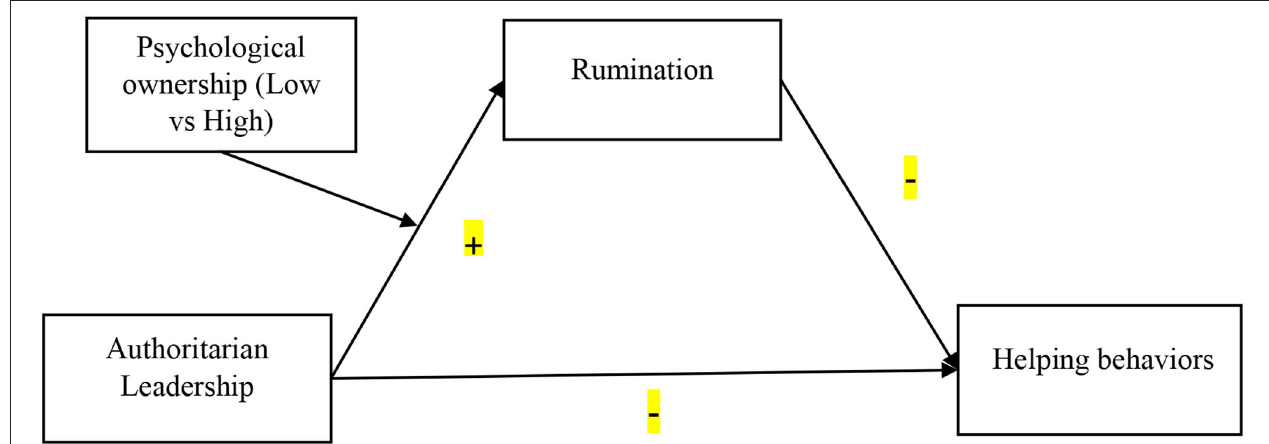
FIGURE 1 | Conceptual